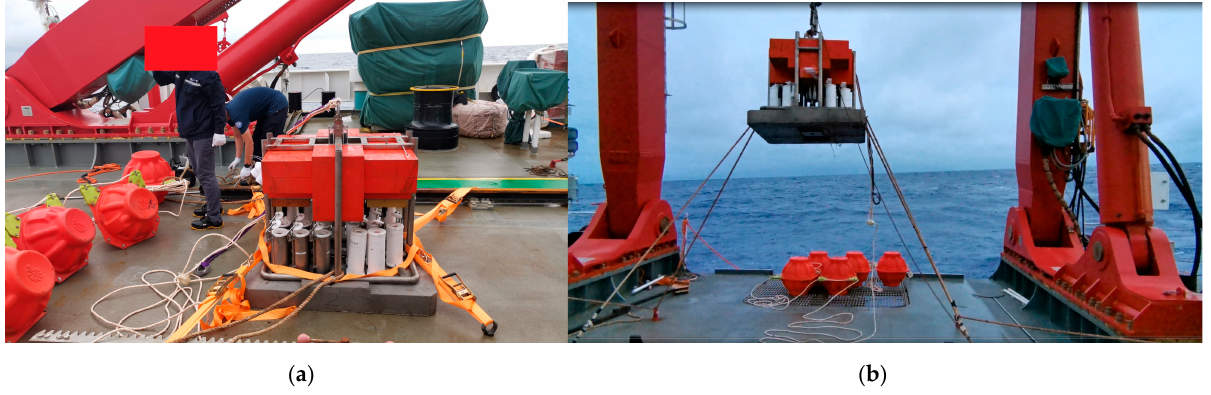
Figure 9. ( a ) The lander on the deck; ( b ) the lander to be released. Table 6. The depth information comes from acoustic release.